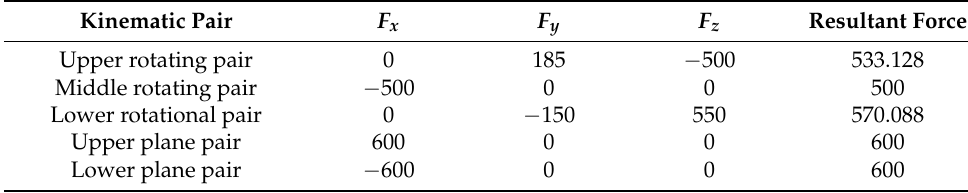
Table 2. Force on moving pair of front wheel connector (N).